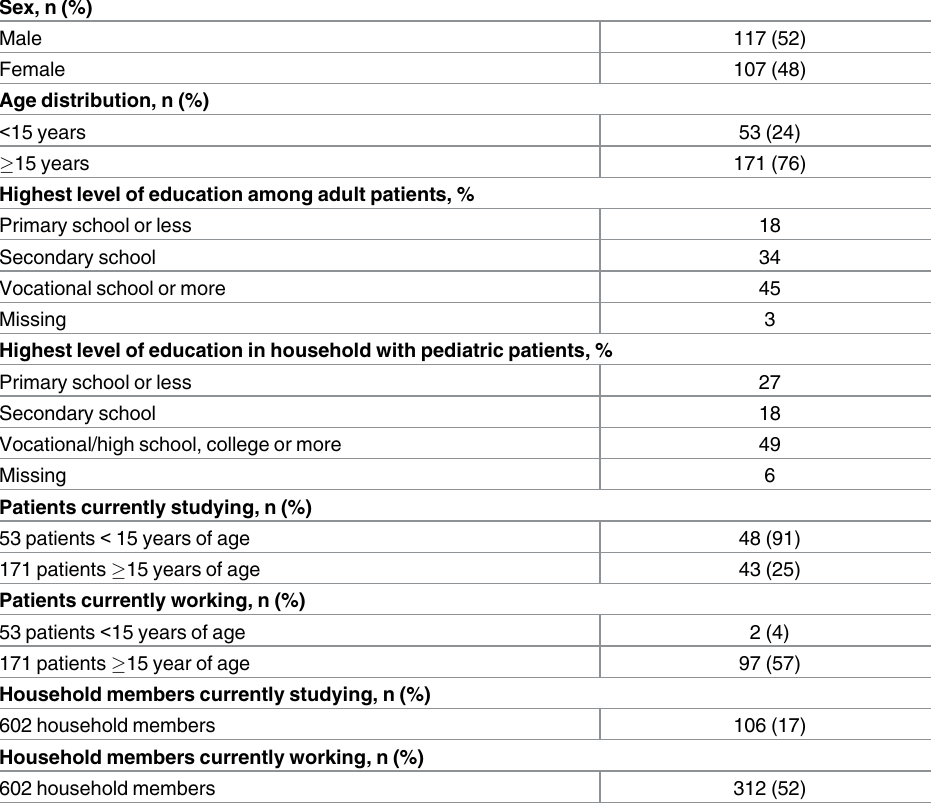
Table 1. General characteristics of the hospitalized dengue patients, Chacheongsao province, Thai- land,